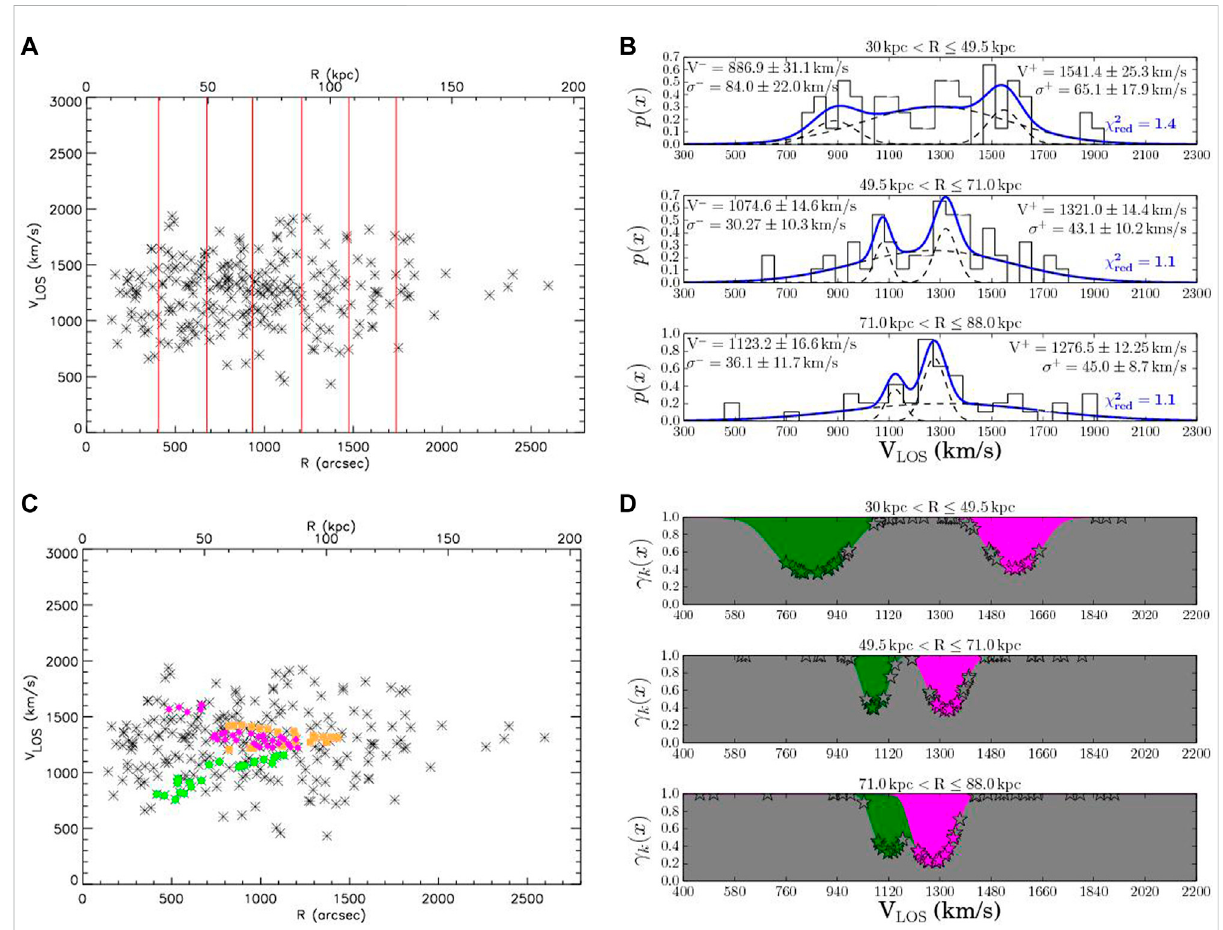
FIGURE 9 (A) : projected phase space, V LOS vs. major axis distance ( R ), for all spectroscopically con fi rmed PNe (black asterisks) in the halo of M87 from Longobardi et al. (2015a). Red lines separate the elliptical annuli to isolate the cold components associated to the substructure. (B) : LOSVD histograms in the three elliptical annuli. In each panel, the blue lines show the best- fi t model computed as a combination of three Gaussians. Black dashed lines show the relative contribution of each component to the LOSVD, with parameters for the cold components given in the plot. (C) : asinthepanel (A) ,however,thegreencirclesandmagentadiamondsshowthePNeassociatedwiththecoldsecondarypeaksintheLOSVD.Orange squares show a kinematically selected GC substructure from Romanowsky et al. (2012). (D) : probability that a PN is drawn from the halo component (dark grey area) or from the chevron (green, magenta areas). Stars represent PN probabilities at their measured V LOS . Image reproduced from Longobardi et al. (2015b) with